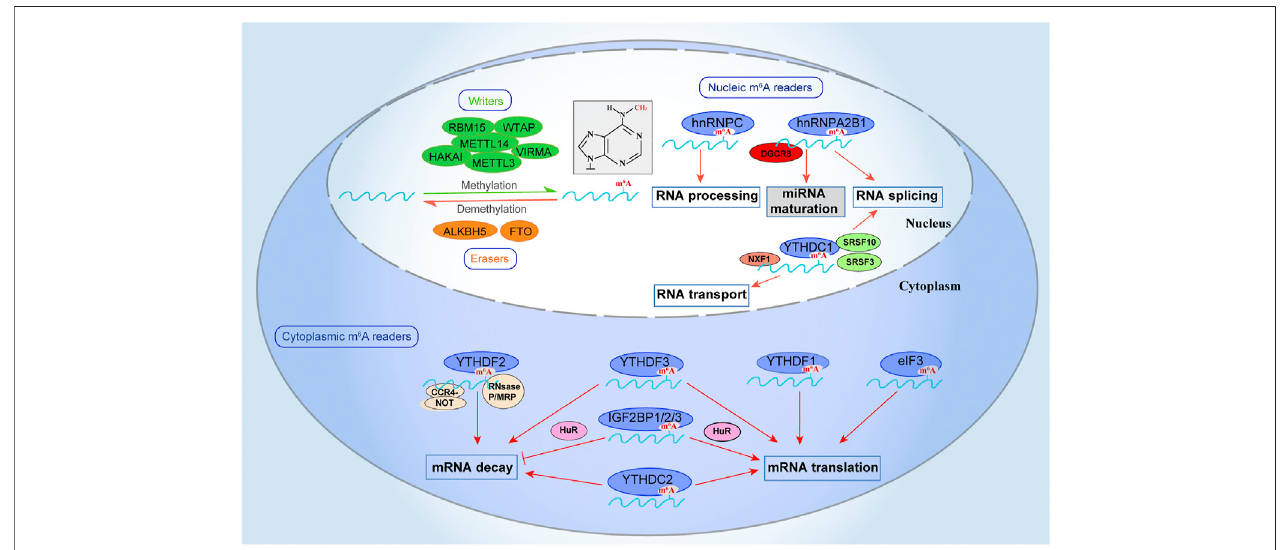
FIGURE 1 | m 6 A-mediated RNA regulation. The m 6 A modi fi cation is integral to the regulation of RNA. m 6 A can be installed by “ writers ” (METTL3/14, WTAP, RBM15, VIRMA, and HAKAI), removed by “ erasers ” (FTO and ALKBH5), and recognized by “ readers ” (YTHDF1/2/3, YTHDC1/2, IGF2BP1/2/3, eIF3, and HNRNPC/ A2B1). m 6 A methyltransferases (writers) catalyze methylation while the m 6 A demethylases (erasers) remove the methyl in m 6 A. The m 6 A recognition (readers) proteins bind the m 6 A modi fi ed transcripts and determine their fate. The modi fi cation of “ writers, ” “ erasers, ” and “ readers ” proteins affect RNA processing, including RNA splicing, mRNA translation, mRNA decay, mRNA export to the cytoplasm, and miRNA maturation.